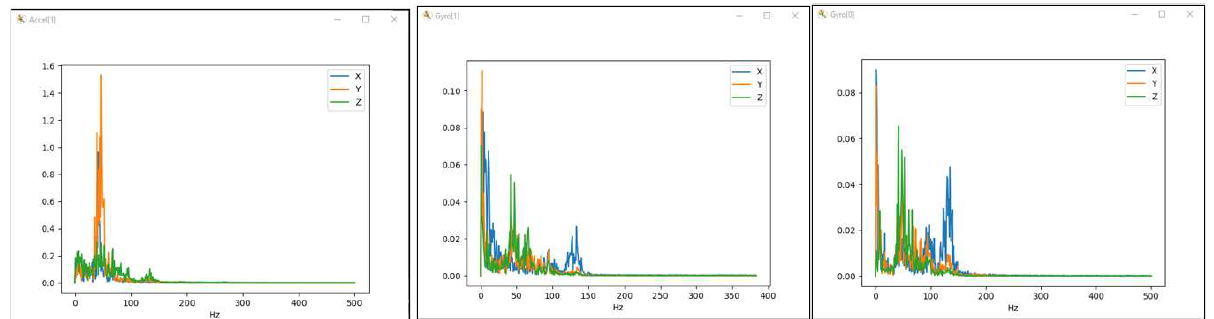
Figure 33. Relative speed of the drone to the ground.